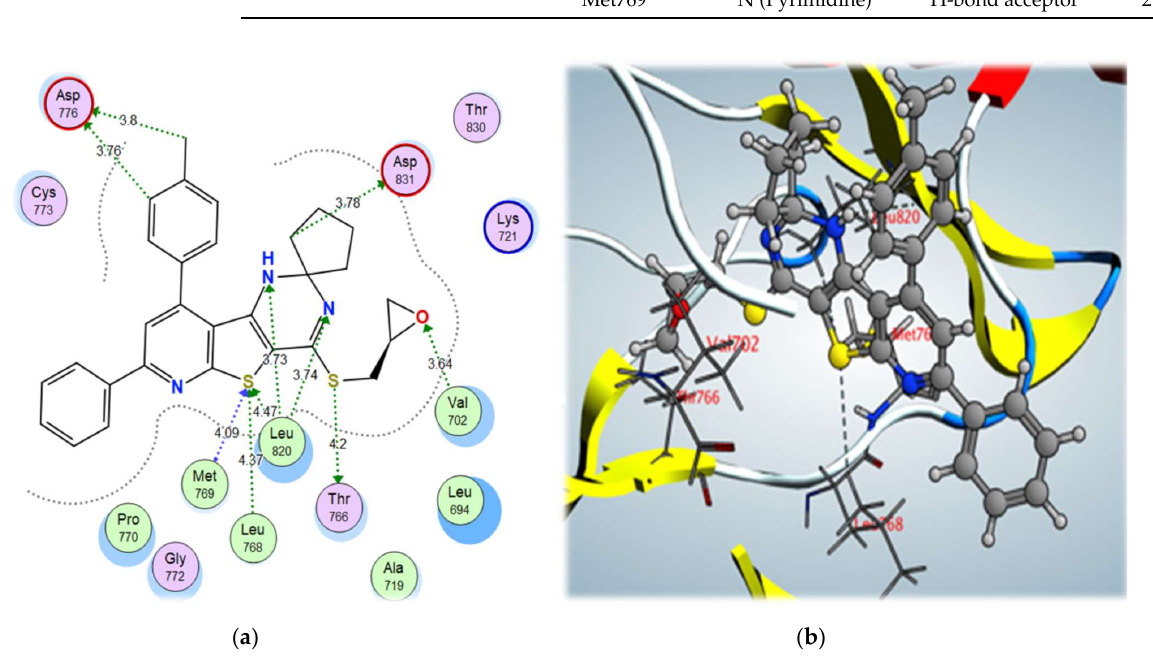
Figure 7. ( a ) 2D interactions and ( b ) 3D interactions of compound 9b within the EGFR kinase domain’s active site.